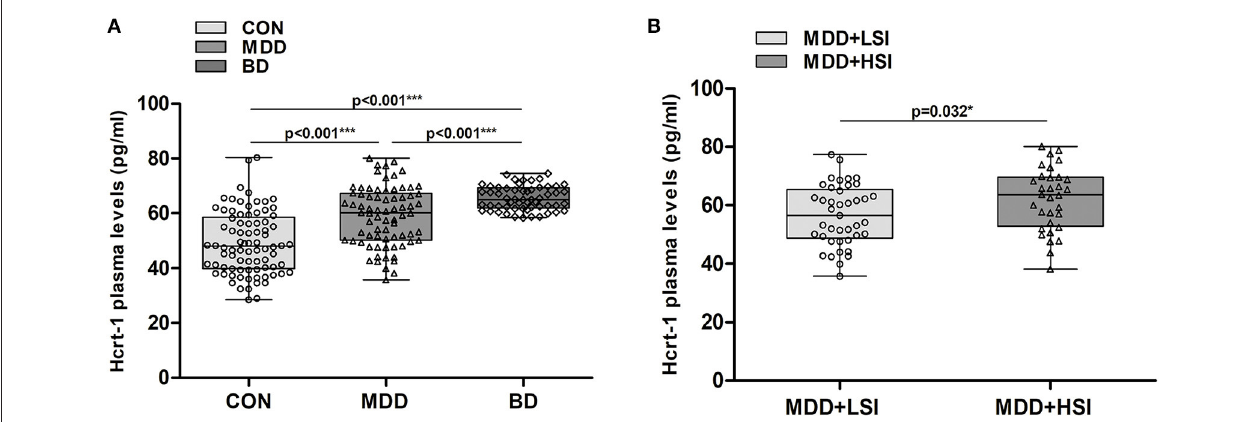
FIGURE 1 | Changes in the hypocretin-1 levels in mood disorder patients. (A) Comparison of hypocretin-1 levels among the control (CON, n = 82), MDD ( n = 74), and BD ( n = 57) groups. Hypocretin-1 plasma levels were significantly higher in MDD and BD patients than in controls. Moreover, hypocretin-1 plasma levels were higher in BD patients than in MDD patients. (B) In the MDD group, patients with higher SI ( n = 33) had higher hypocretin-1 levels than those with lower SI ( n = 41).